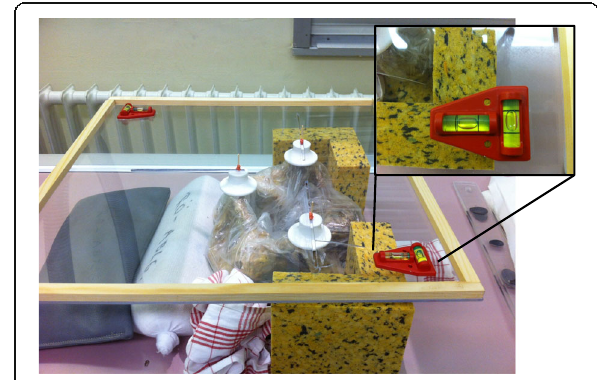
Fig. 2 Positioning device II: a wood-framed acrylic glass plate with three different guide slots that allowed for individual positioning of the pegs; the pegs were placed on the superior anterior iliac spines and the pubic symphysis; additional spirit levels (insert) were installed for the horizontal